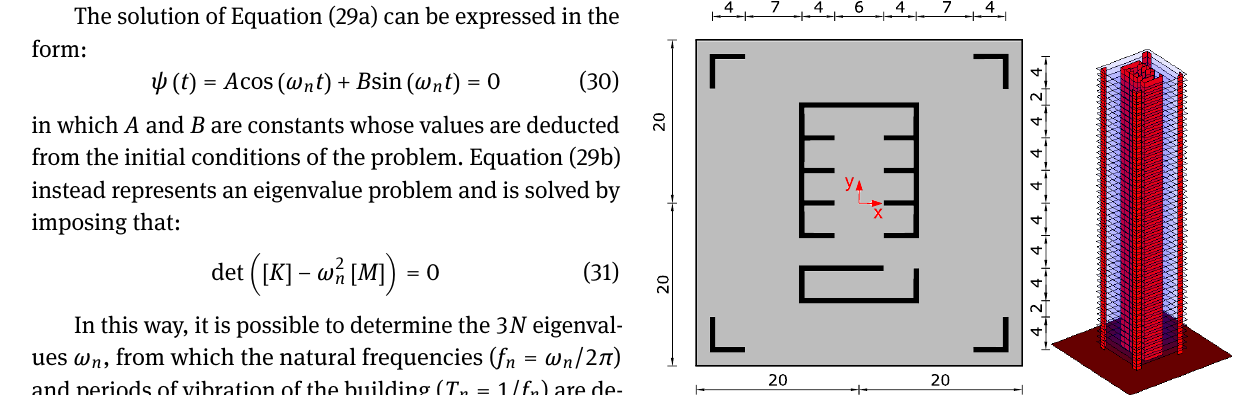
y G = −7.82 × 10 −2 m. The polar moment of inertia,